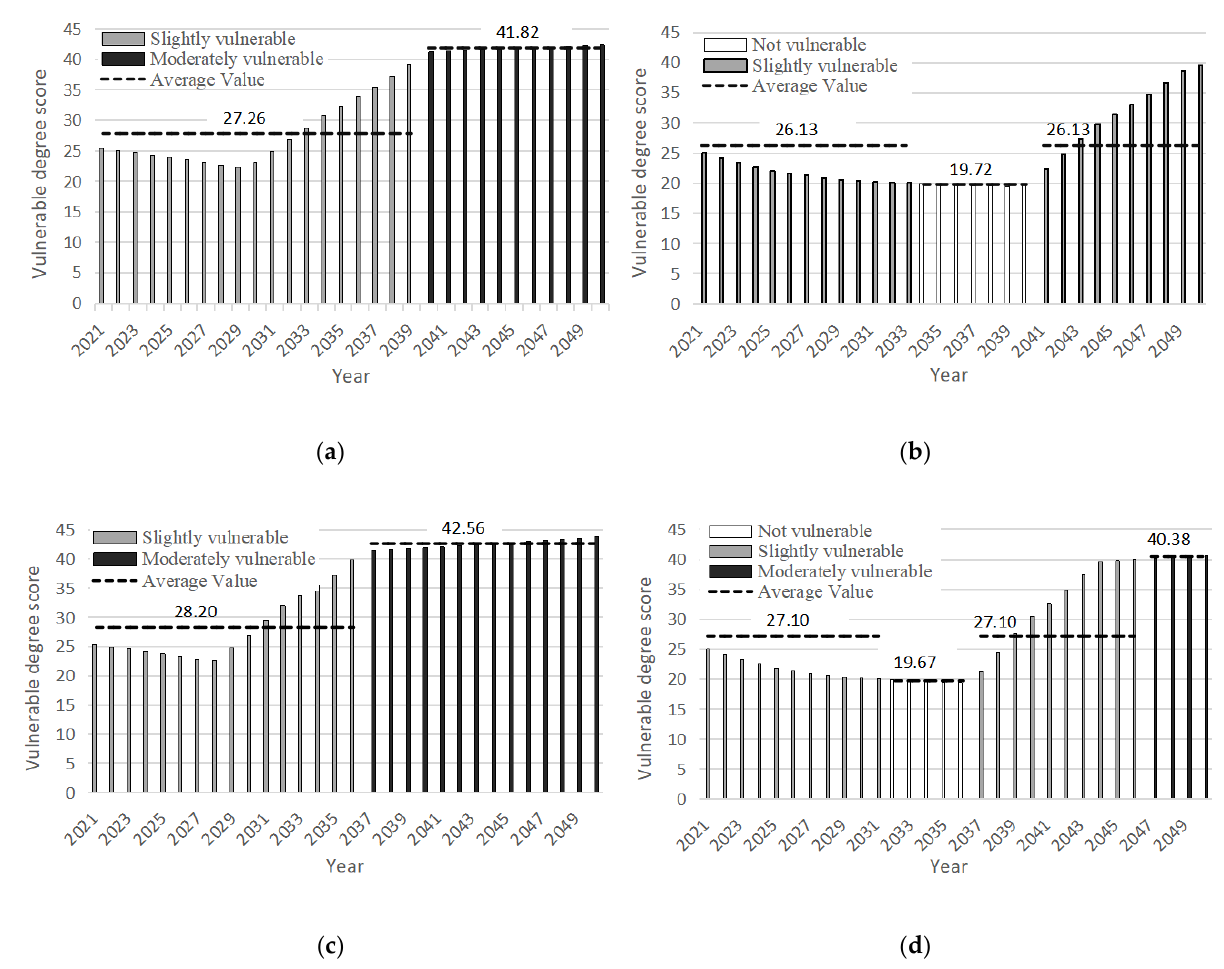
Figure 4. Vulnerability score and grading in different scenarios. ( a ) Scenario 1; ( b ) scenario 2; ( c ) scenario 3; ( d ) scenario 4.